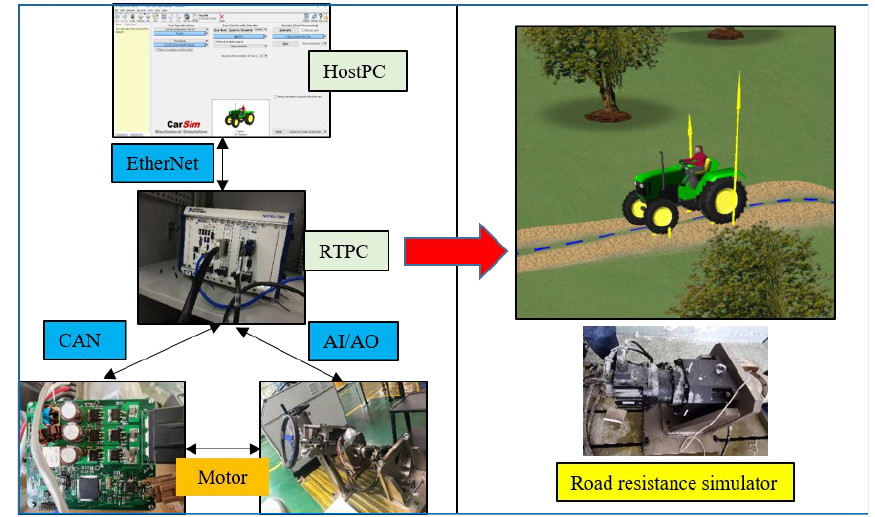
Figure 10. Hardware-in-the-loop simulation